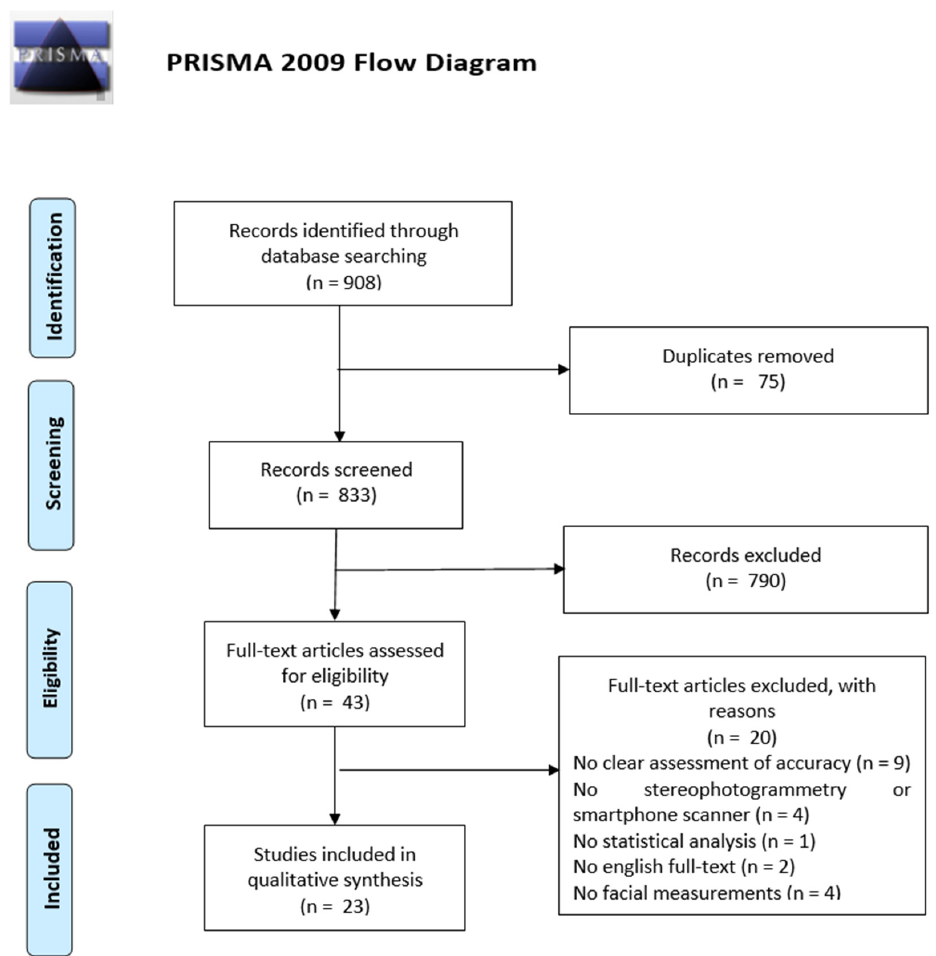
Figure 1. PRISMA flow diagram of the searching strategy and results.